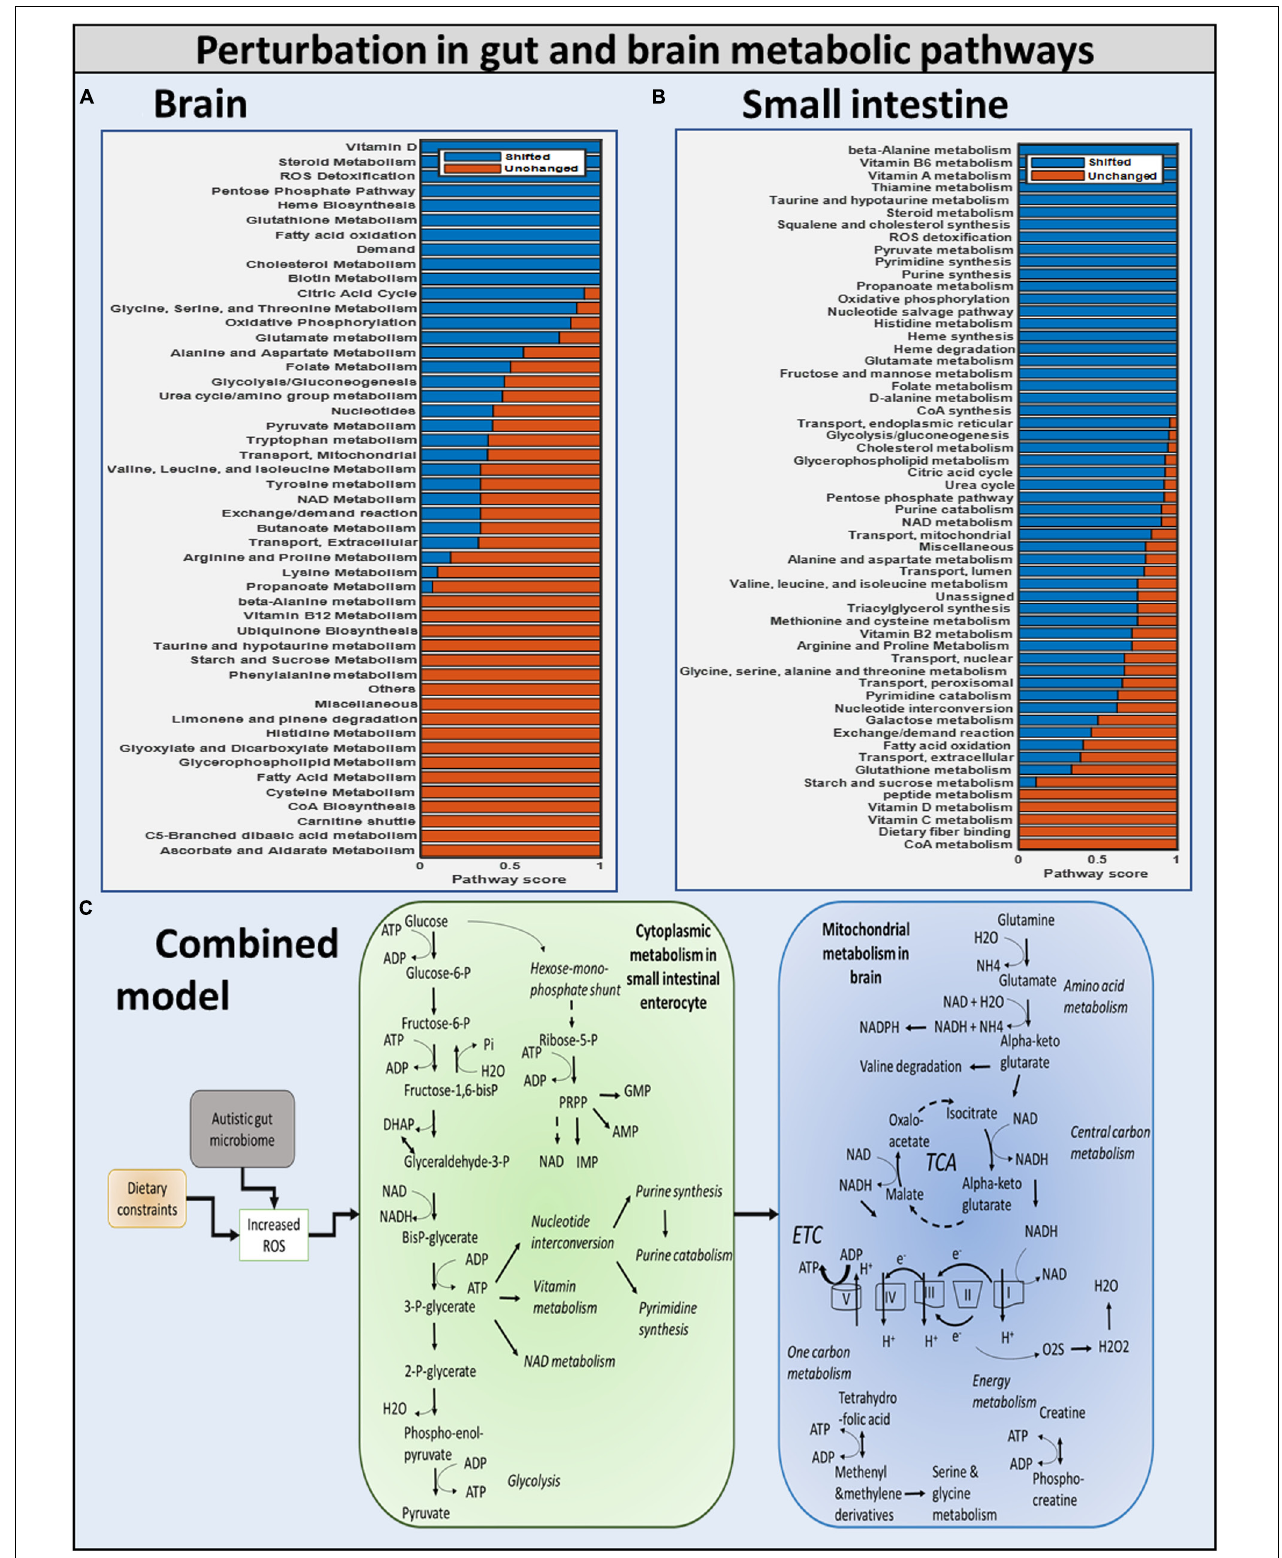
FIGURE 10 | Summary of the modulation of metabolic pathways in autism. (A) Brain model: brain metabolic pathways perturbed due to dietary intervention. (B) Small intestinal model: SIEC metabolic pathways perturbed. (C) Combined model: overall shift in metabolism of brain and SIEC host.